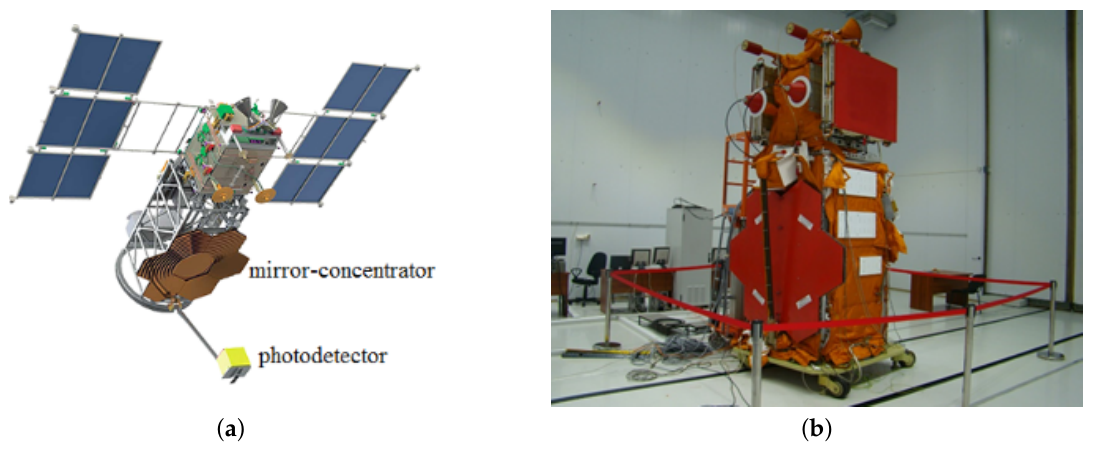
Figure 1. The TUS (Tracking Ultraviolet Setup) detector on board the Lomonosov satellite ( a , an artist’s view). TUS on board the Lomonosov satellite covered with a protective cover during preflight preparations ( b